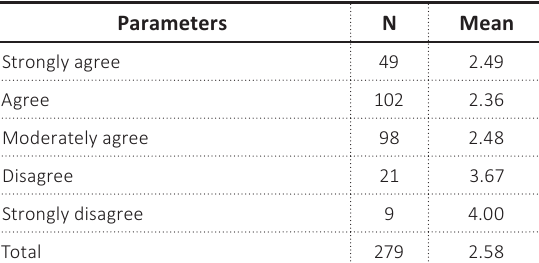
Table 10. EFD use in audit and tax compliance mean extracts